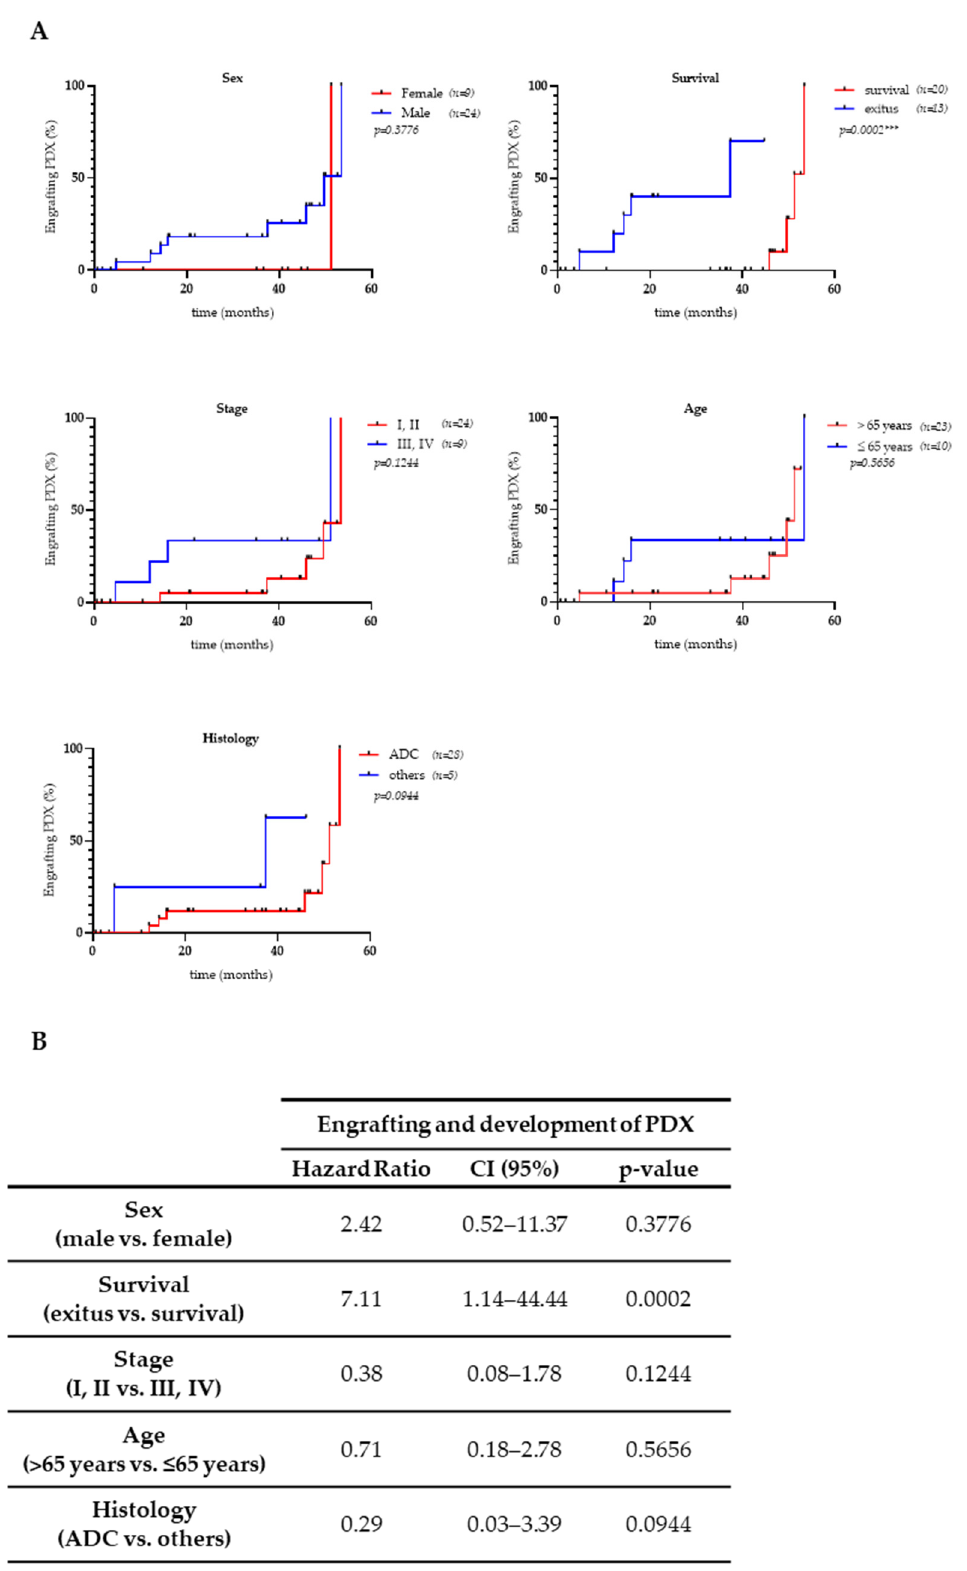
2. Table 3 should be replaced with the following Table